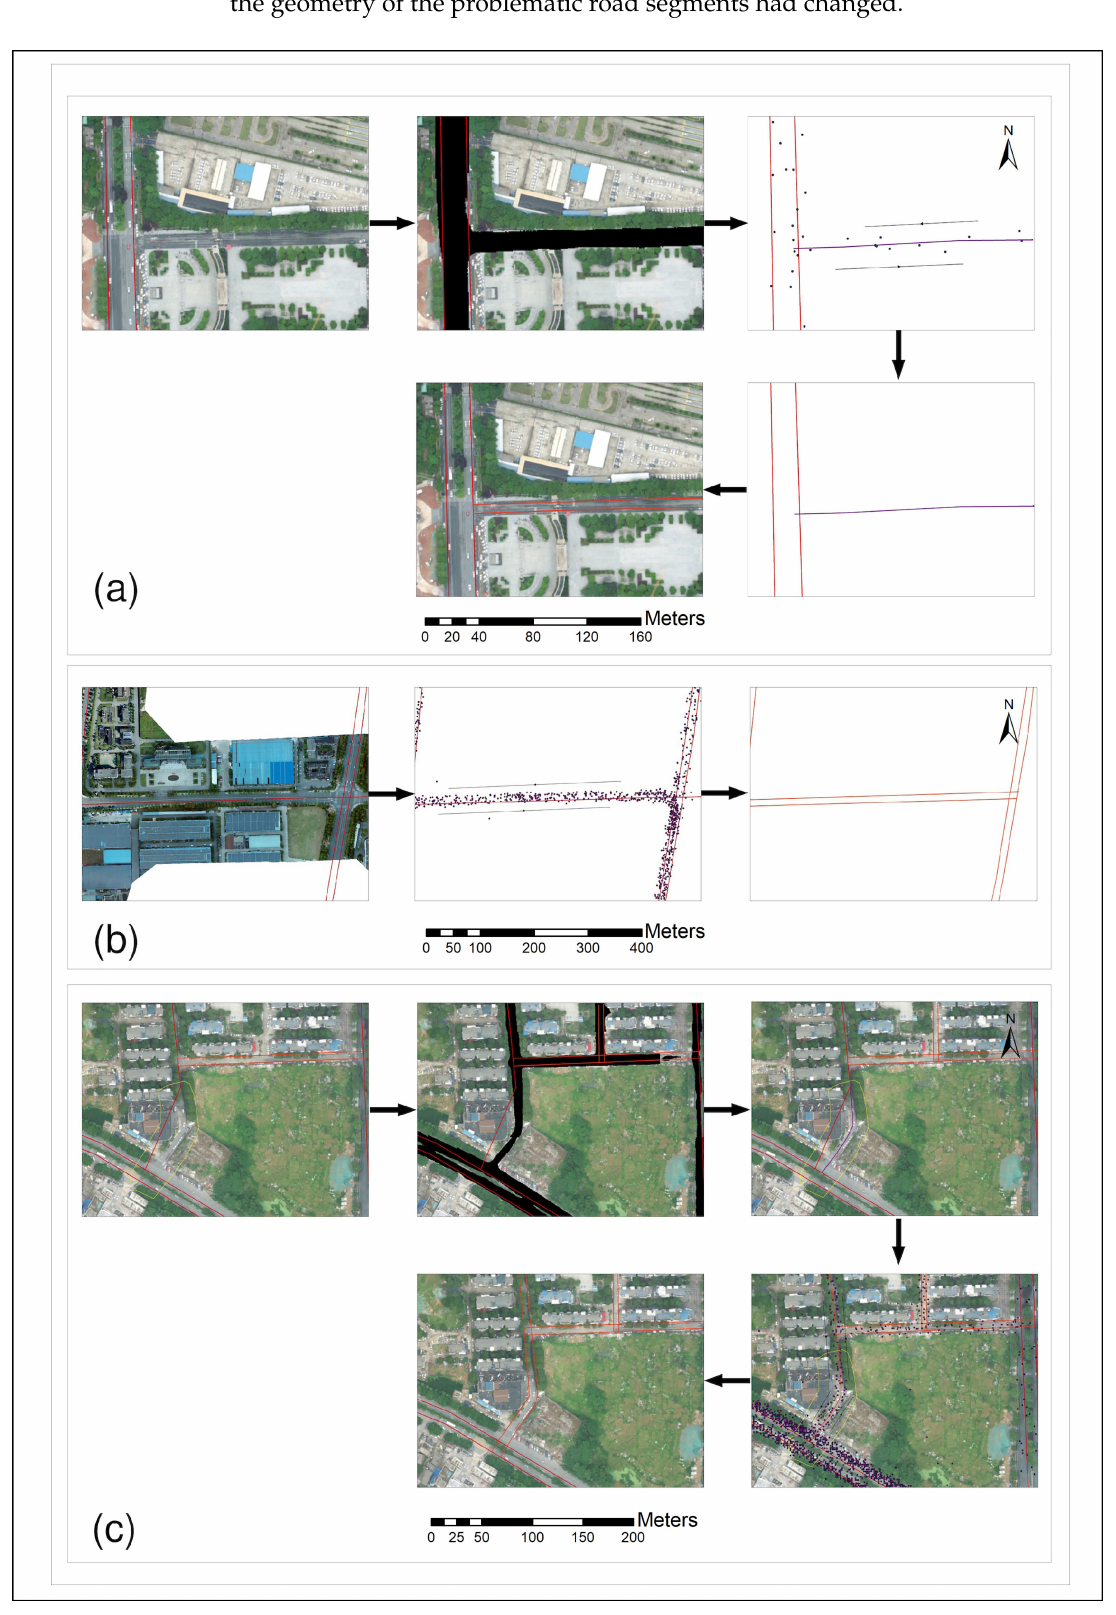
Figure 9. Update process for road segment: ( a ) the new road segments; ( b ) the problematic segments where the geometry has not changed; and ( c ) the problematic segments where the geometry has